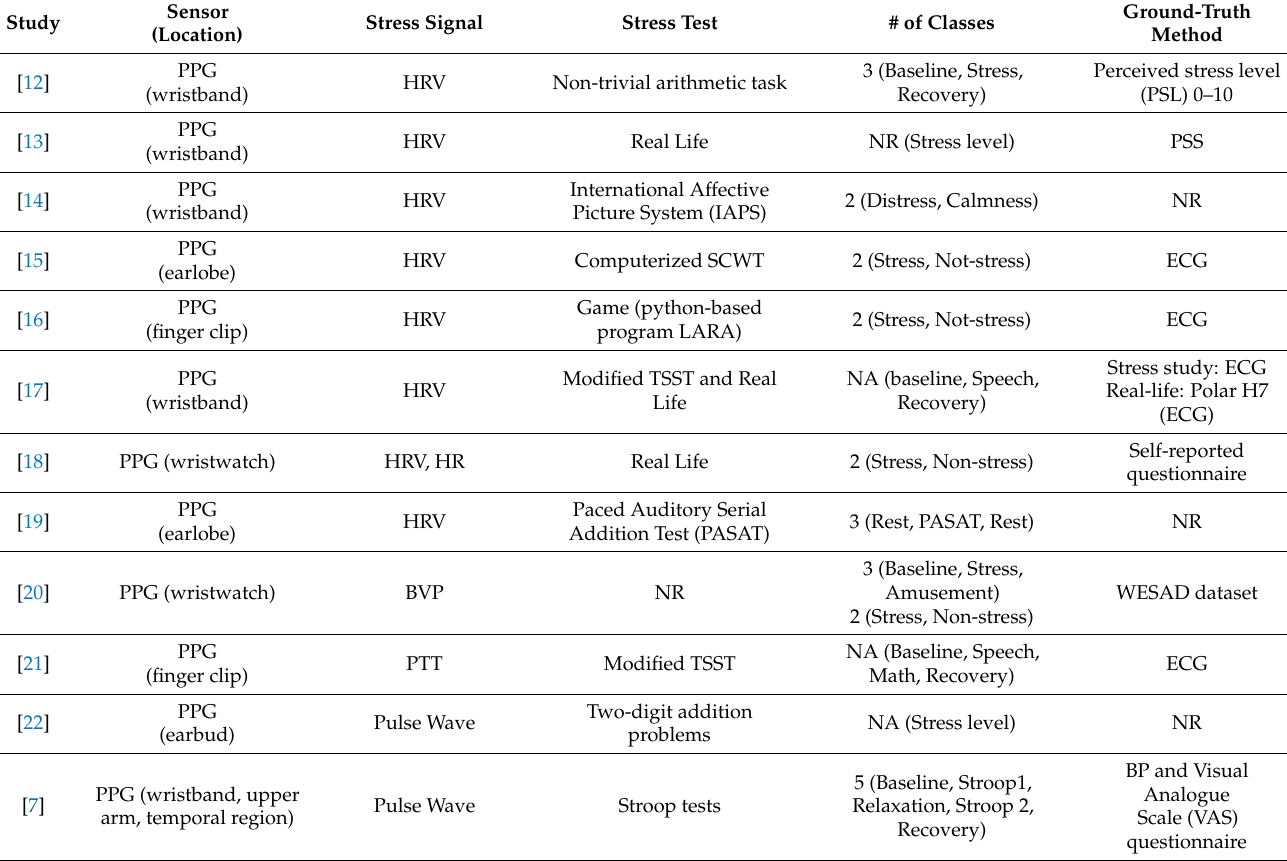
Table 3. Stress detection studies in clinical and real-life